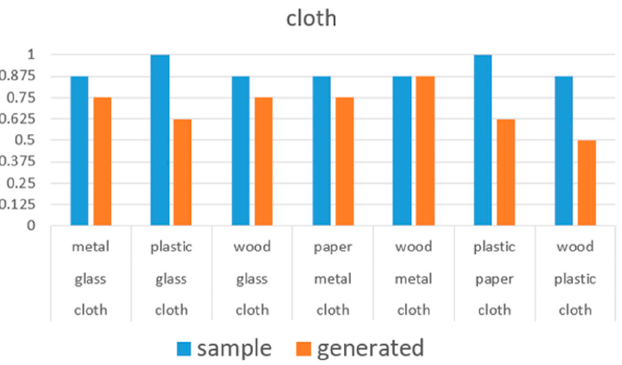
Figure 22. Accuracy of “cloth” class in main (generated) and preliminary (sample) experiments.